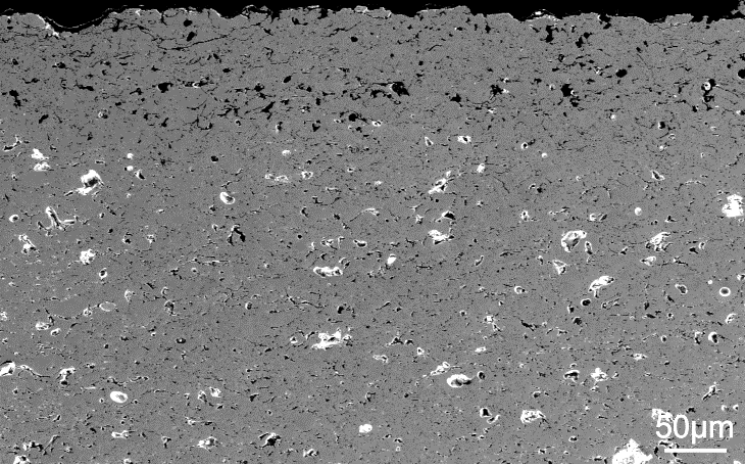
Figure 9. SEM image of a through-thickness cross section near the surface, sample 4SH38D—1200 °C/10 hrs; a higher porosity is visible at the surface.